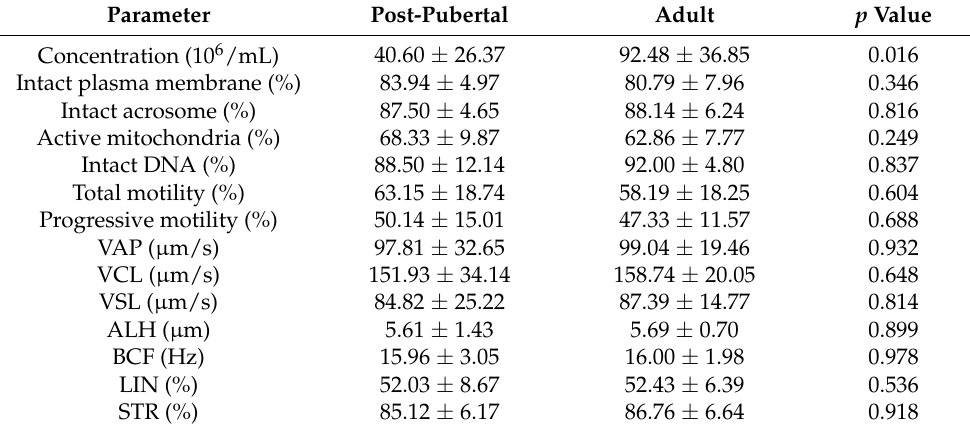
Table 3. Epididymal sperm parameters in <1-year-old (post-pubertal, n = 9) and >1-year-old (adult, n = 7) sexually mature tomcats.